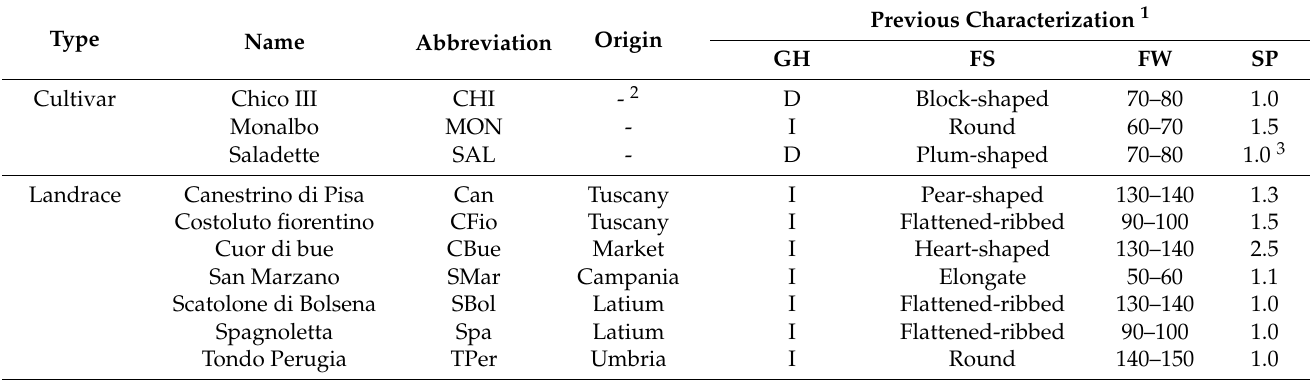
Table 1. Name, abbreviation, origin, and previous characterization of the ten studied genotypes, including growth habit (GH; D determinate, I, indeterminate), fruit shape (FS), fruit weight (FW, g), and stigma position (SP, score, 1 = inserted; 2 = as the same level as stamens; 3 = slightly exserted; 4 = very